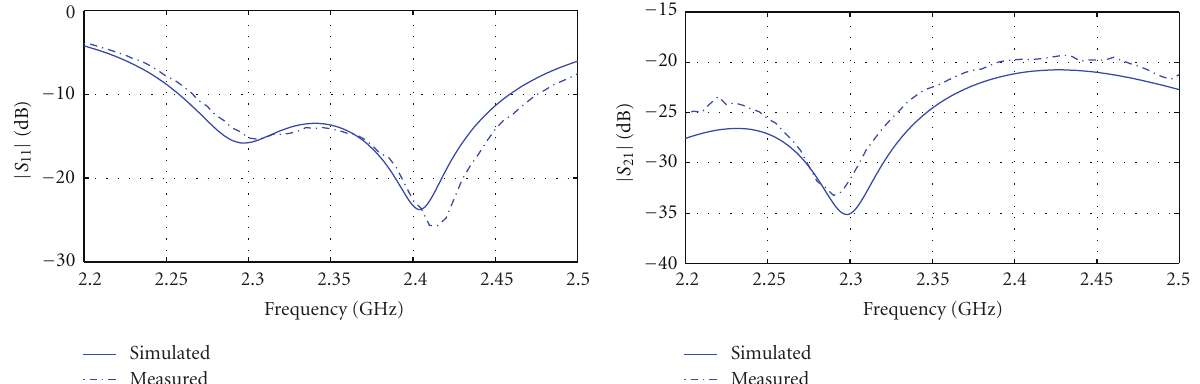
Figure 4: Simulated (full line) and measured (dashed-dotted line) reflection coe ffi cient of a single element and mutual coupling between two neighboring array elements.